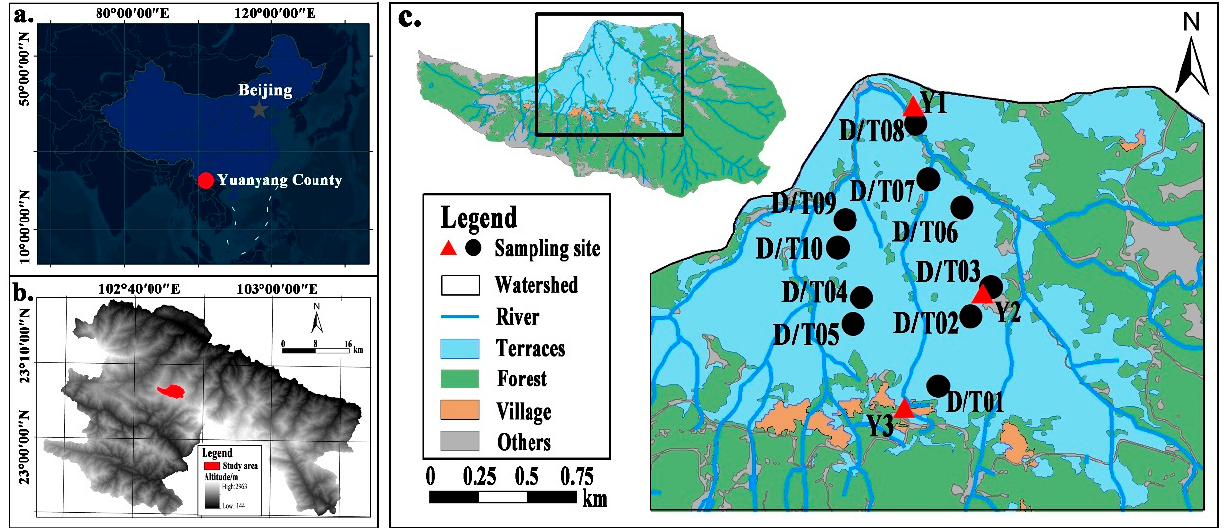
Figure 1. ( a ) Location of the Quanfuzhuang River Basin (QBS), ( b ) topography of the Yuanyang County, and ( c ) landscape pattern of the Quanfuzhuang River Basin (QBS). The black solid circles in ( c ) indicate the sampling site of terrace water and groundwater (T01–T10 and D01–D10, respectively); the red solid triangles in ( c ) indicate the sampling site of precipitation (Y1–Y3); and the weather station is located at Y3.